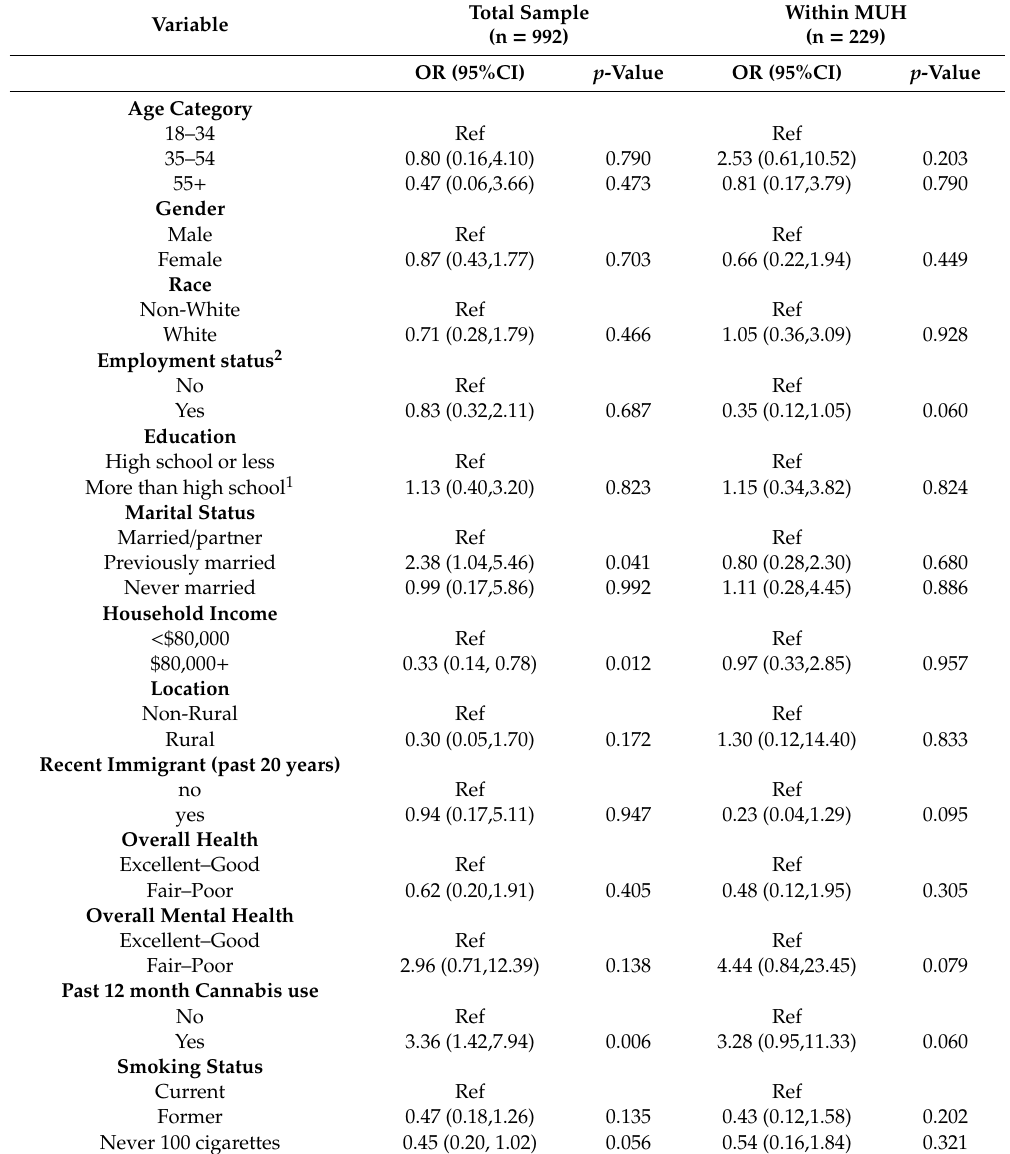
Table 4. Odds Ratios of Exposure to Environmental Cannabis Smoke Versus Non-exposed Individuals Living in Multi-Unit Housing, Ontario, Canada,